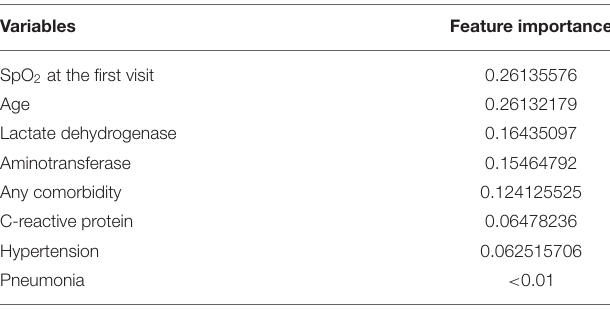
TABLE 4 | Feature importance of XGboost with eight